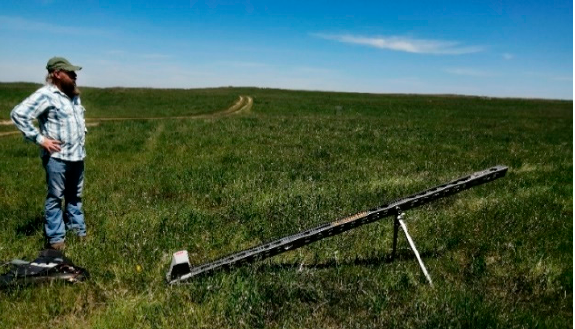
Figure 1. UAVs’ types that are used in precision agriculture; ( a ) six rotary-winged, ( b ) large fixed-winged, ( c ) VTOL (Vertical Take-Off and Landing), ( d ) four rotary-winged, ( e ) mini fixed-winged, and ( f ) large VTOL.